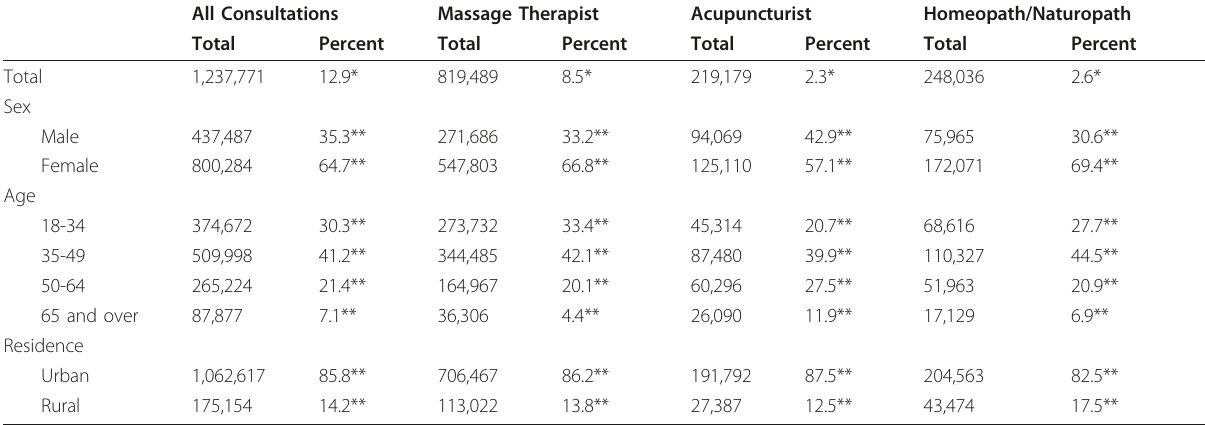
Table 2 Consulted an Alternative Health Care Provider: Population Aged 18 or over in Ontario, 2005 All